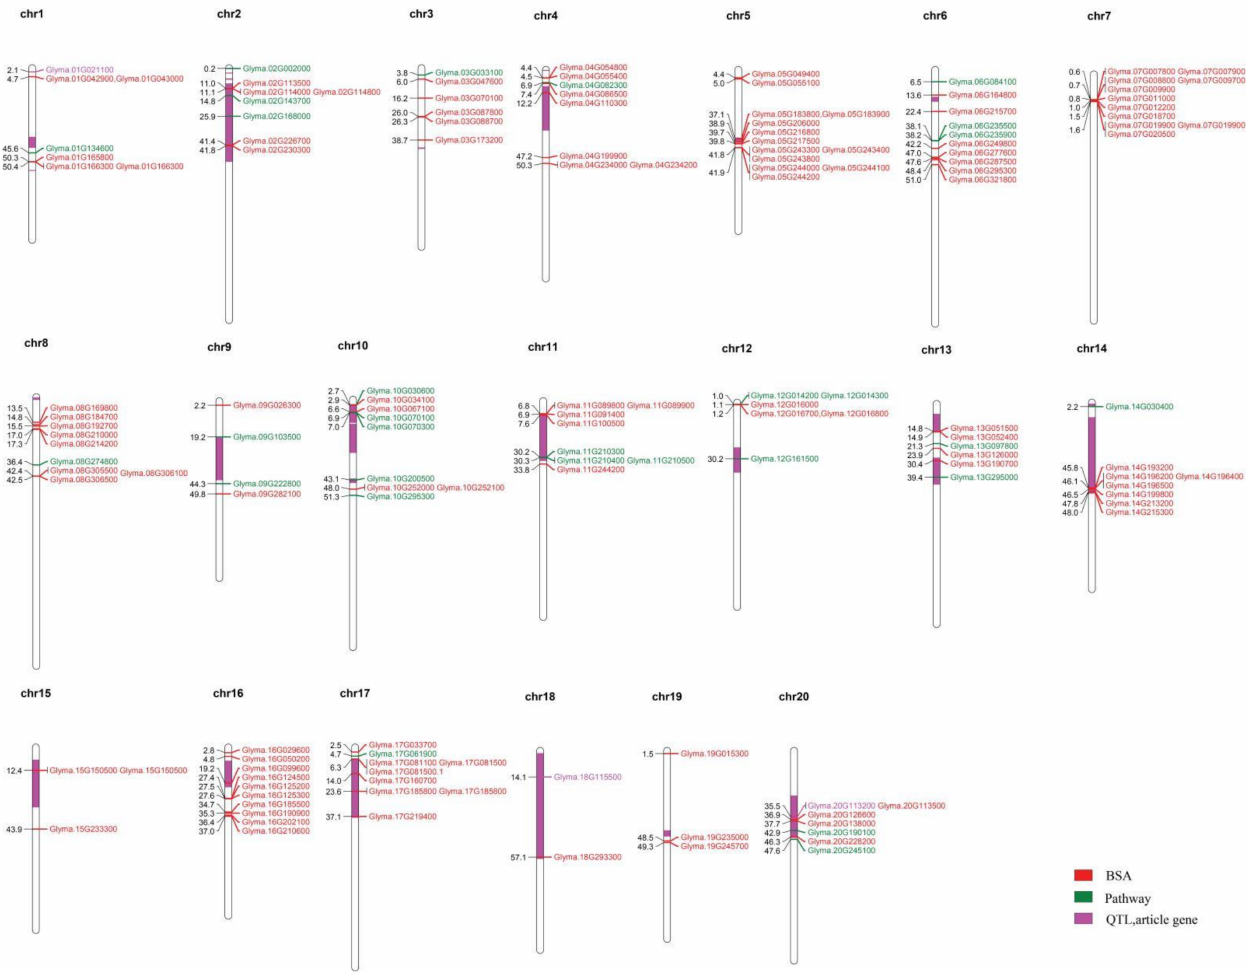
Figure 1. The positions of tocopherol-related loci and corresponding candidate genes on different chromosomes of